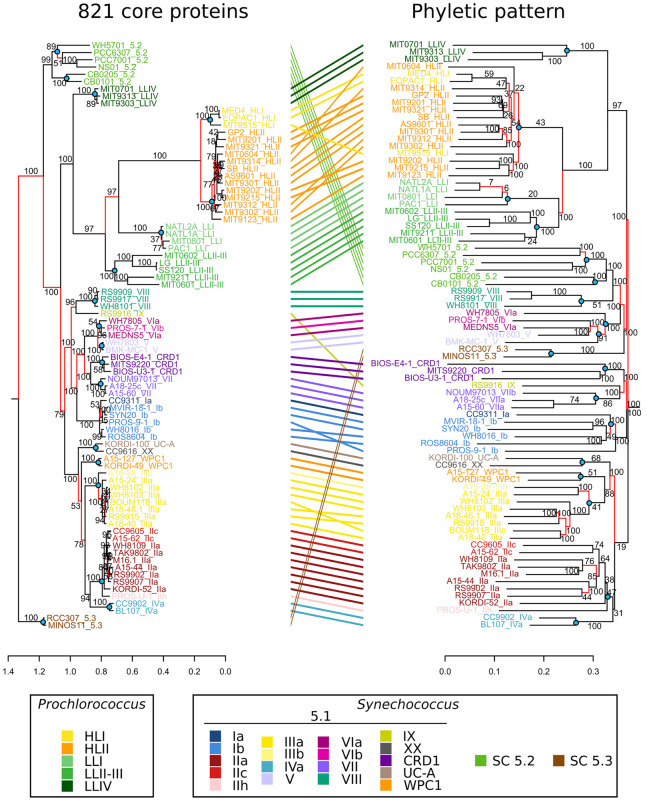
Comparison of phylogenies based on core protein sequences and phyletic patterns of non-core genes. Left, Maximum Likelihood tree based on the alignment of 821 concatenated core proteins. Right, Neighbor-Joining tree based on the Jaccard distance between the phyletic patterns of 27,376 accessory gene families found in the 81 picocyanobacterial genomes. Labels are colored according to the strain sub-clade. Red branches indicate discrepancies between the topology of the two trees. Nodes located at the base of a clade and highlighted by blue dots were used for branch length comparisons in Supplementary Figure S4.